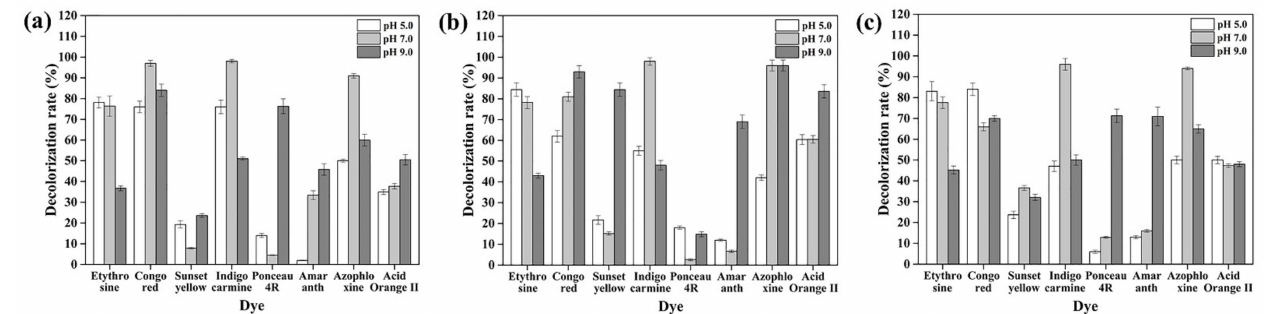
Figure 7. Decolorizing synthetic dyes with purified rLAC using mediator ABTS ( a ), acetosyringone ( b ), and syringaldehyde ( c ) at different pH values (5.0, 7.0, and 9.0). The operation was conducted through incubation of 80 U rLAC at 60 ◦ C. All experiments were conducted in triplicate, and the data represent mean ±